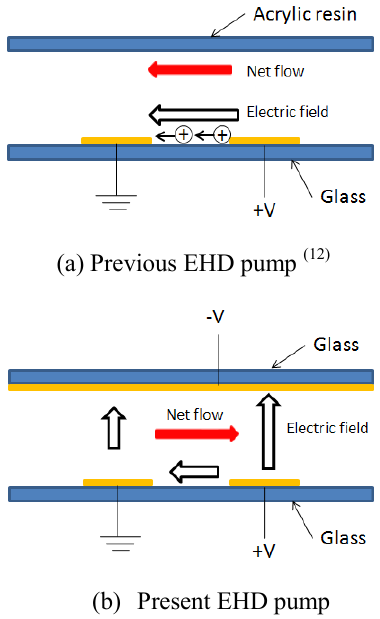
Fig. 1 Illustrations of our previous and present EHD